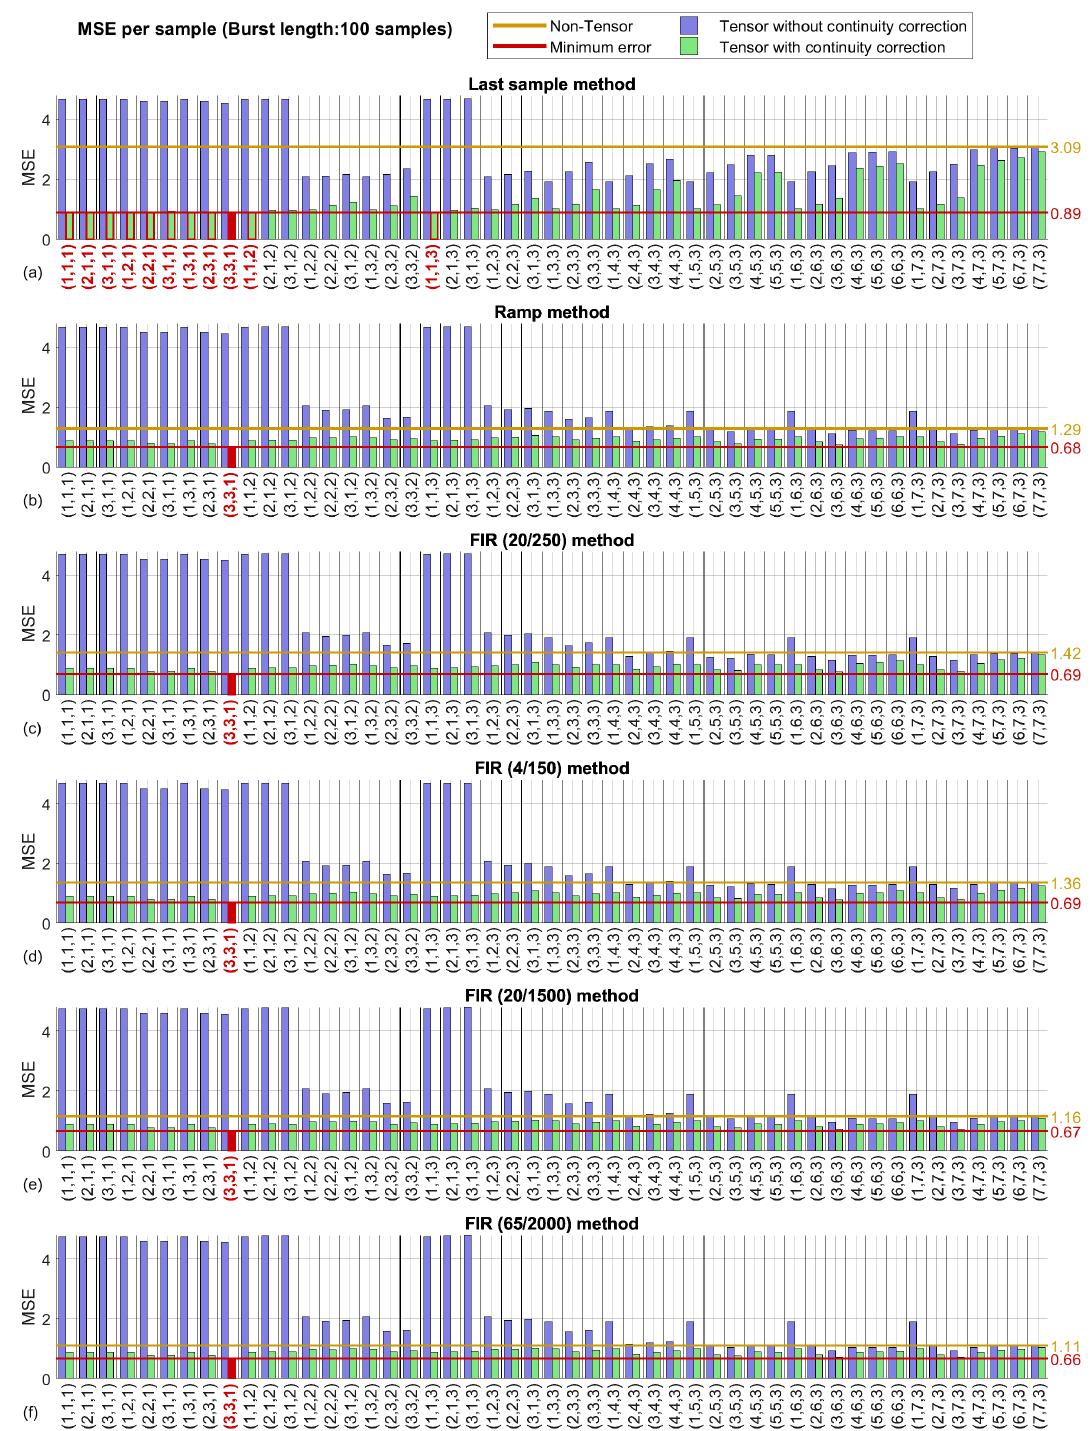
Figure 10. MSE per sample of the Tucker decomposition depending on the core tensor. The MSE of the restoration is shown with the continuity correction and without it. The bars marked in red have an error no bigger than 5% of the